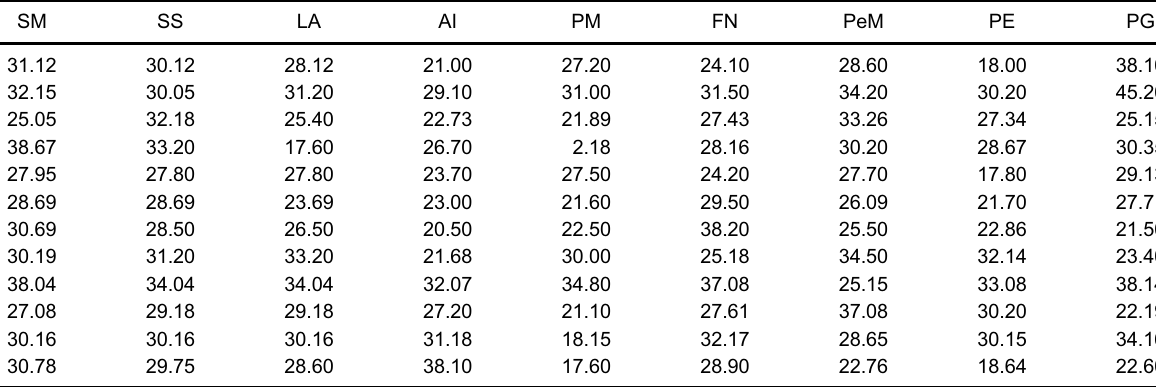
Table 2. Quantity of examined cariogenic bacteria DNA in negative control samples.